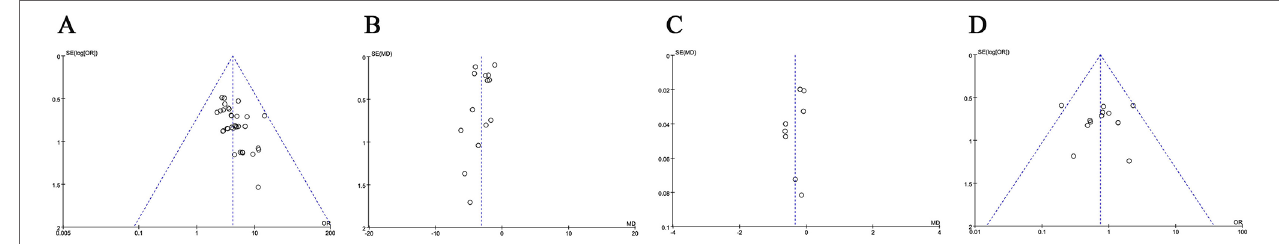
FIGURE 7 | Funnel plot of overall response rate (ORR, A ), National Institutes of Health Stroke Scale (NIHSS, B ), plasma viscosity (PV, C ) and total adverse effects (TAE, D ).